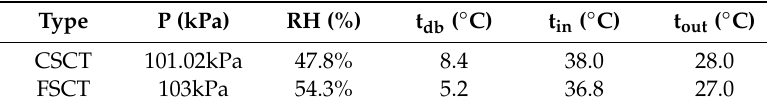
Table 3. Operation parameters for cooling tower.